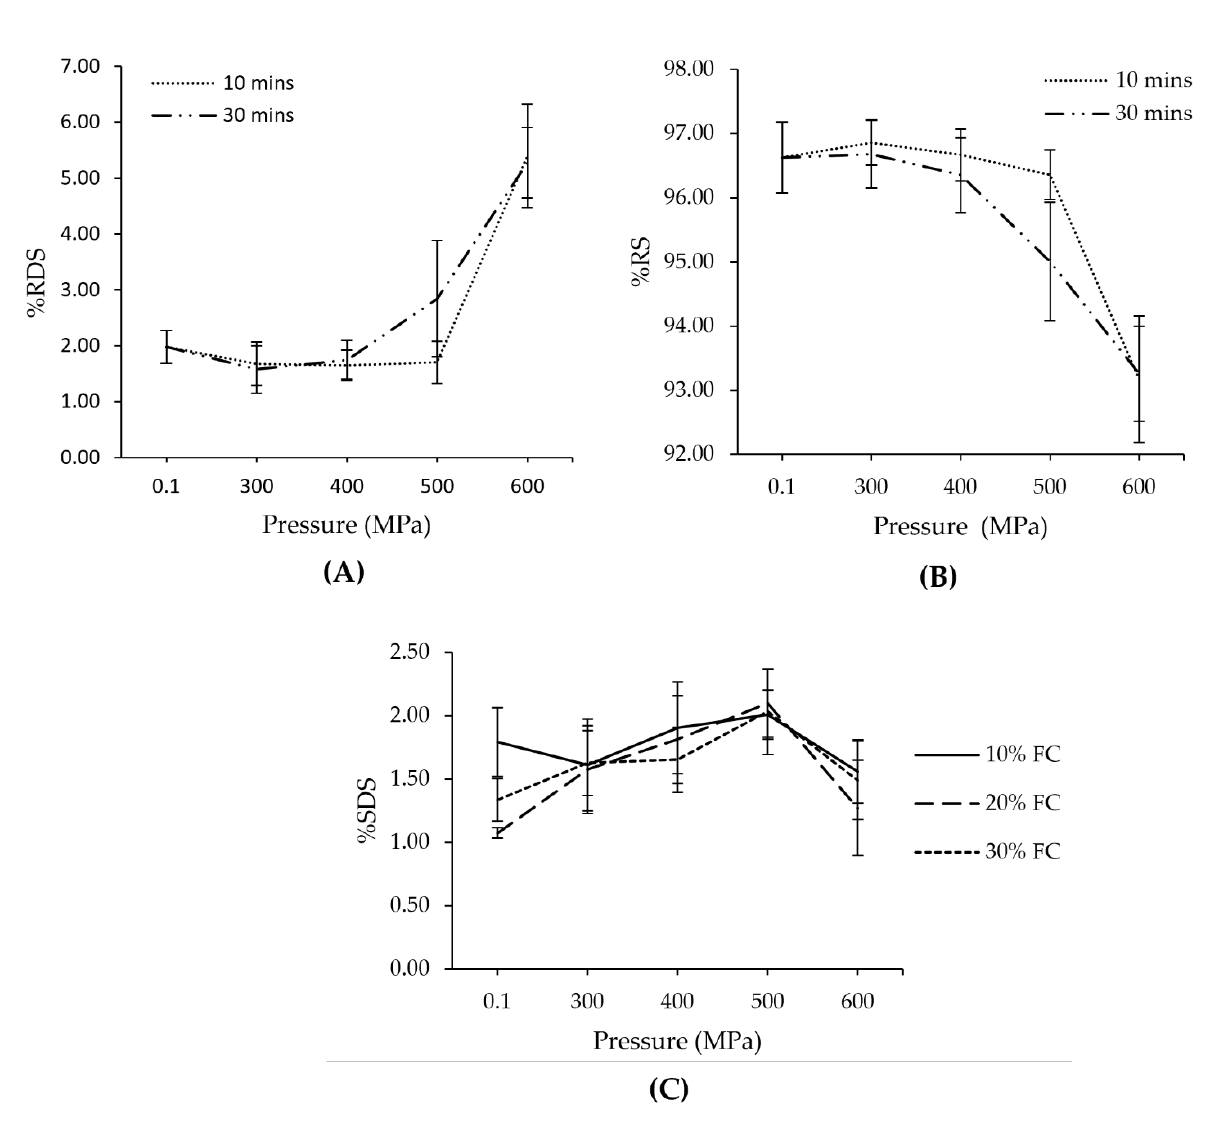
Figure 7. Two-way interactions of %RDS (pressure ∗ HT; ( A )), %SDS (pressure ∗ FC; ( C )), and %RS (pressure ∗ HT; ( B )) for untreated and HPP-treated cassava flour. Rapidly digestible starch (RDS); slowly digestible starch (SDS); resistant starch (RS); and flour concentration (FC). Error bars represent ± standard deviation (n = 3).